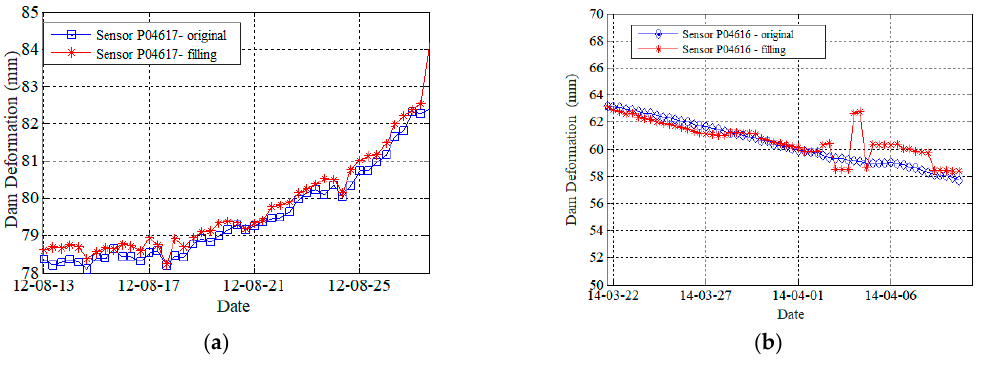
Figure 10. The illustration of filling results in different sensors’ readings. ( a ) Sensor P04617; ( b ) sensor P04616.